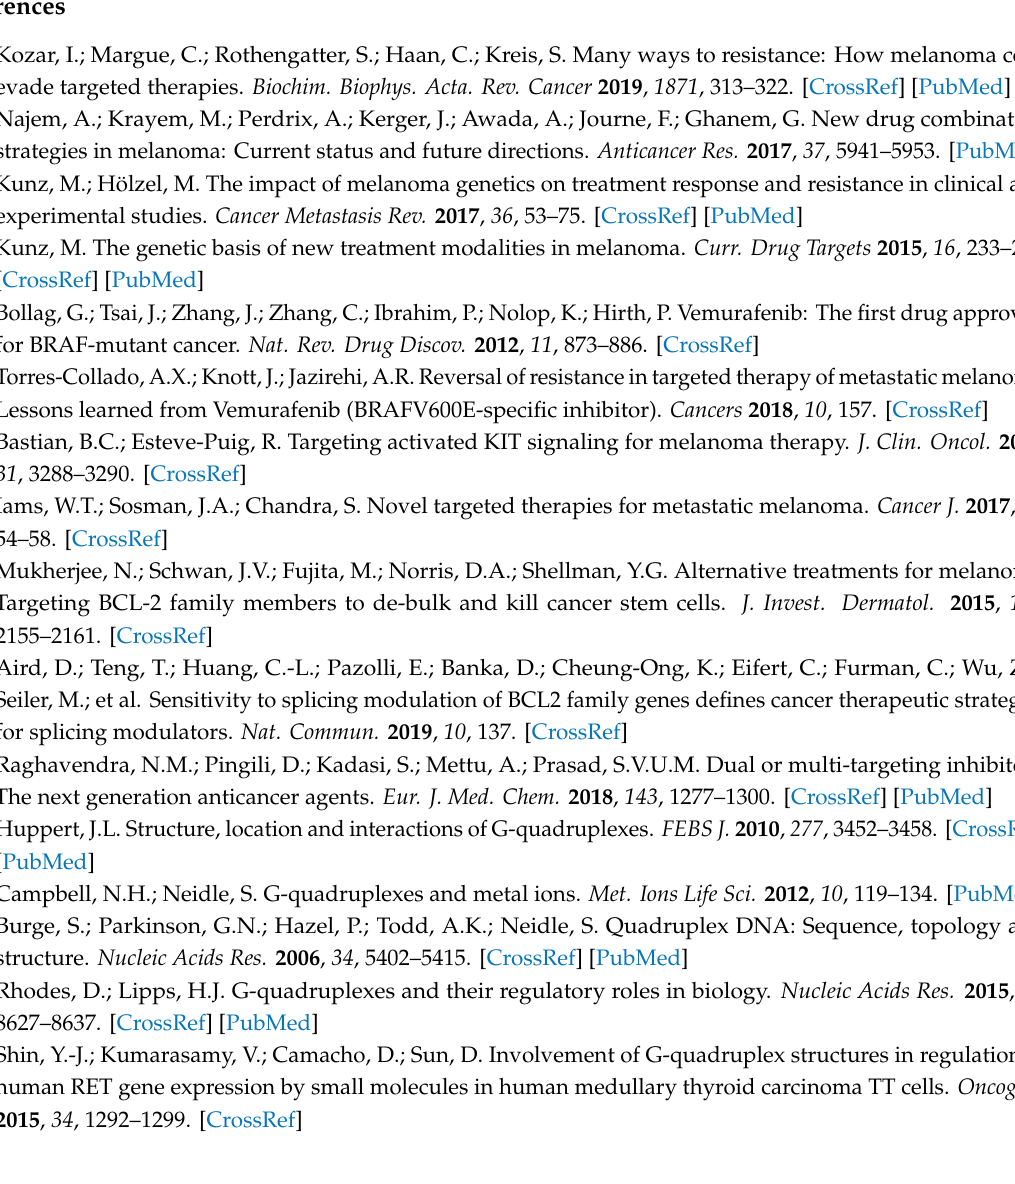
c-kit2, and b-raf G4 oligonucleotides; Figure S4: FRET analysis of c-kit2 and dsDNA oligonucleotides; Table S1: Oligonucleotides used in this study; Table S2: Cytotoxic activity of 1 on primary skin fibroblasts and cell lines established from human solid tumors of di ff erent histological origins; Table S3: Analysis of gene expression levels in melanoma cells upon 48 h of exposure to 1 ; Table S4: Over-representation analysis of the most relevant enriched pathways found in the list of di ff erently expressed genes in treated vs. untreated melanoma cells; HPLC purity data; 1H- and 13C-NMR spectra of c-exNDIs 11 and 12 ; characterization of the c-exNDIs 11 and 12 ; supplementary